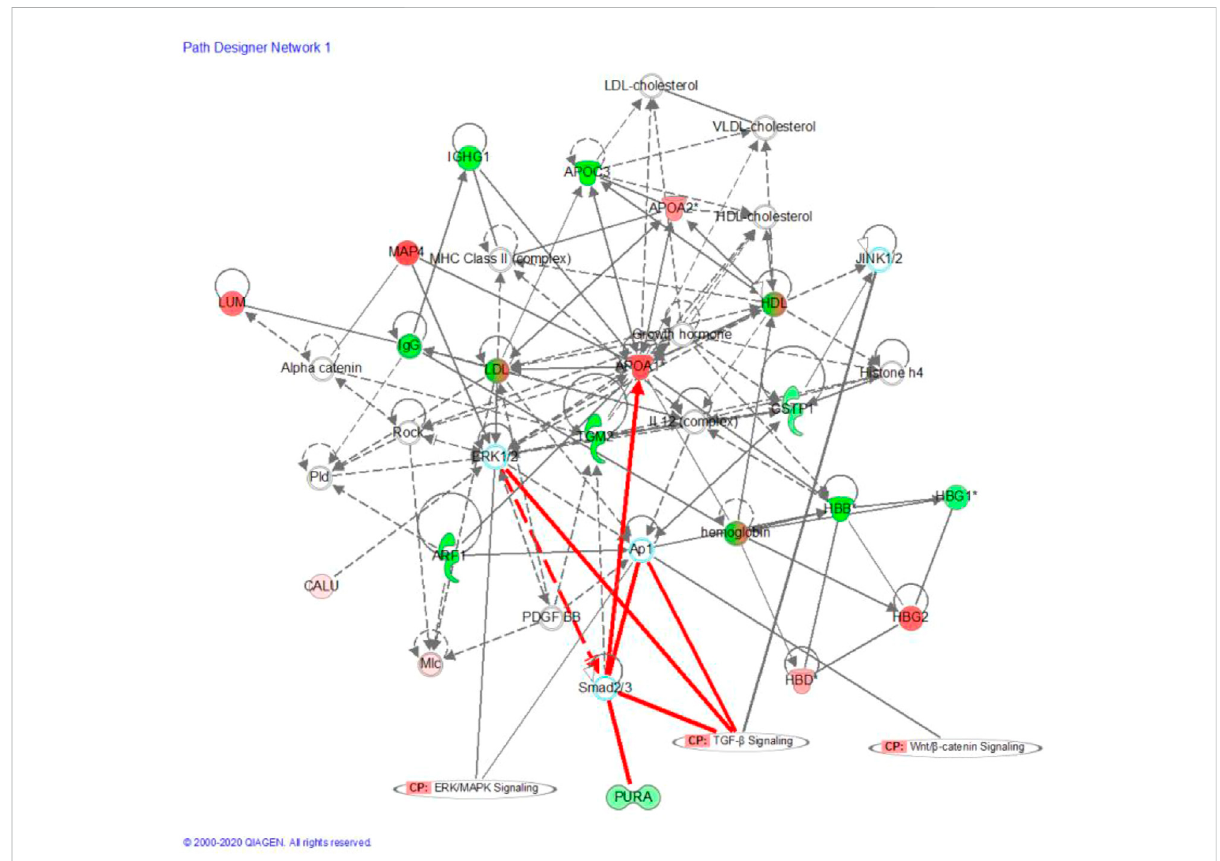
FIGURE 5 Precursor protein of DEPs analysis by Ingenuity Pathway Analysis (IPA); Red and blue dots represent the signi fi cantly up- and downregulated DEPs related Precursor Proteins, respectively; “ CP ” is an abbreviation for “ canonical pathway, ” which represents a signaling pathway related to the highly linked molecules. Indirect relationships are represented by dotted lines and direct relationships by solid